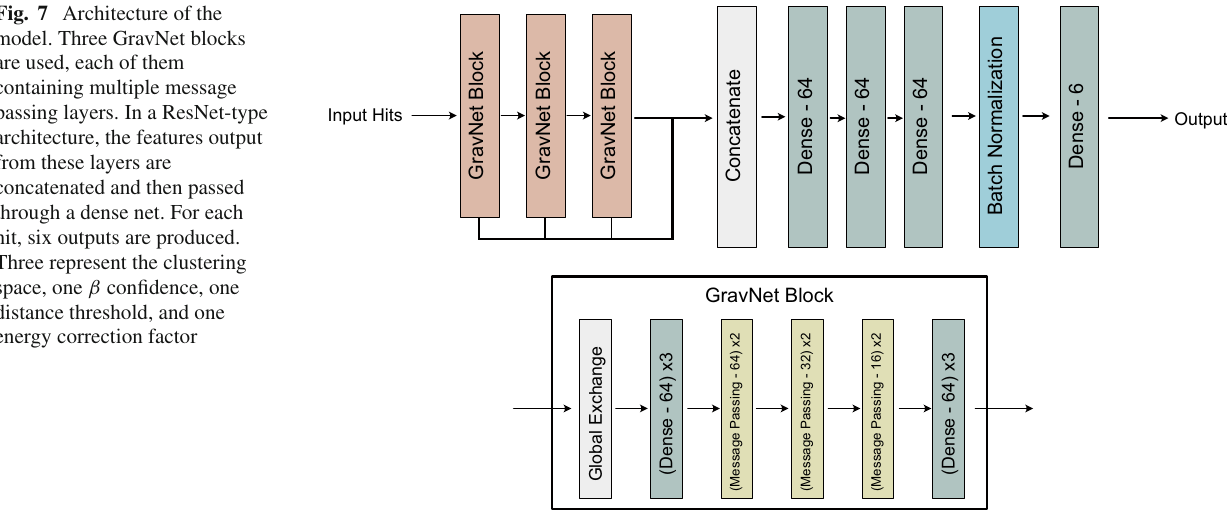
Fig. 7 Architecture of the model. Three GravNet blocks are used, each of them containing multiple message passing layers. In a ResNet-type architecture, the features output from these layers are concatenated and then passed through a dense net. For each hit, six outputs are produced. Three represent the clustering space, one β confidence, one distance threshold, and one energy correction